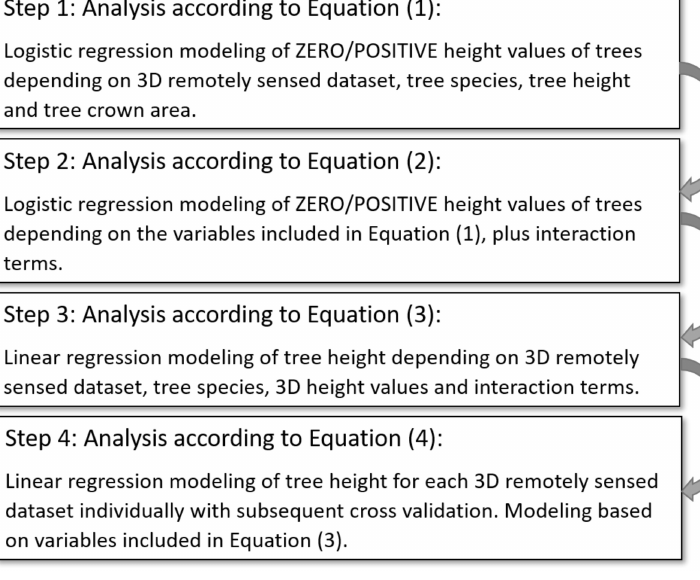
Table 4. Distribution of trees by 3D remotely sensed dataset for different tree species and tree height classes according to three categories of h max a for the tree polygons ( n = 530). Percent in brackets. Tree Species Height (m) ALS: Norway spruce